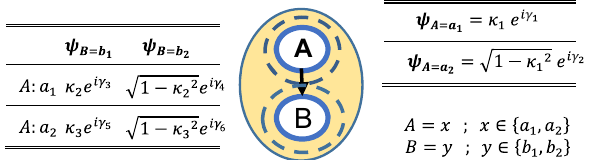
Figure 2. An entangled bayesian network including two nodes. Each node (A and B) is considered a part of the whole system (illustrated by a yellow oval). The nodes in the social system are entangled due to unknown sources such as trust and cooperation between agents. In the BEQBN, probabilities in BNs are replaced by suitable complex wave functions.